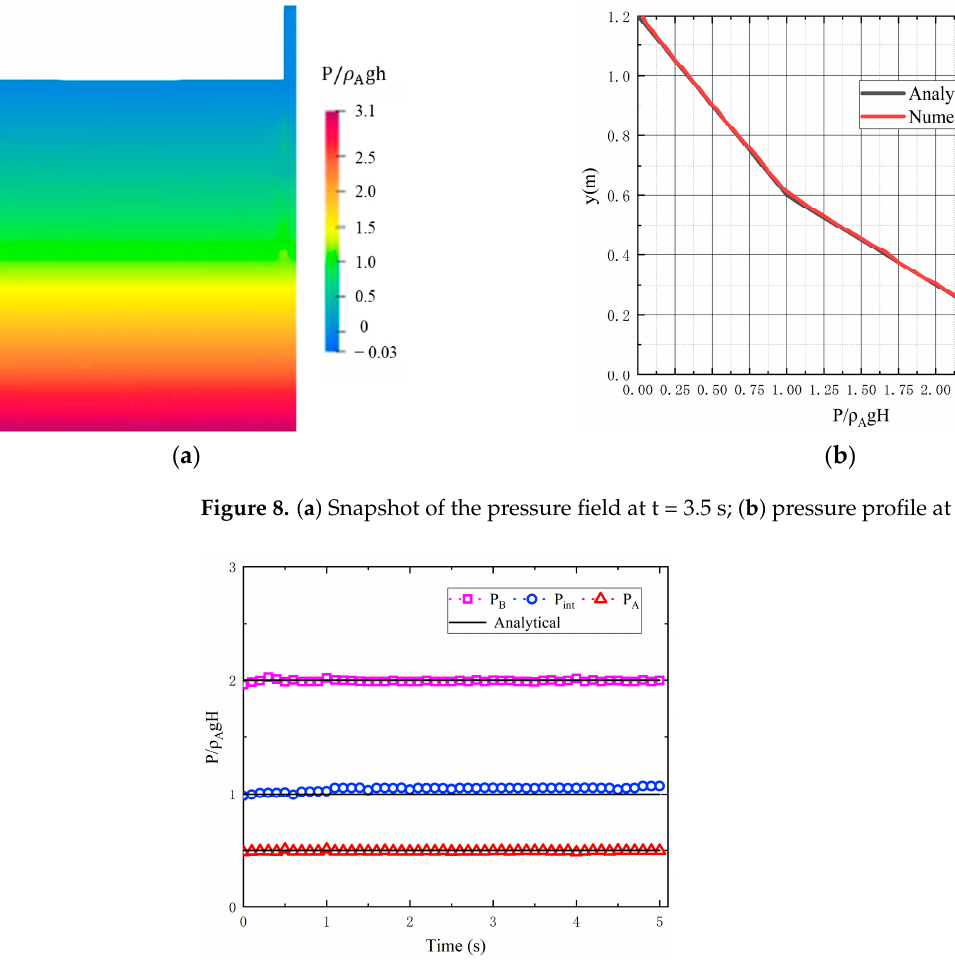
Figure 9. Pressure history of the three monitor probes P A , P B , and P int .